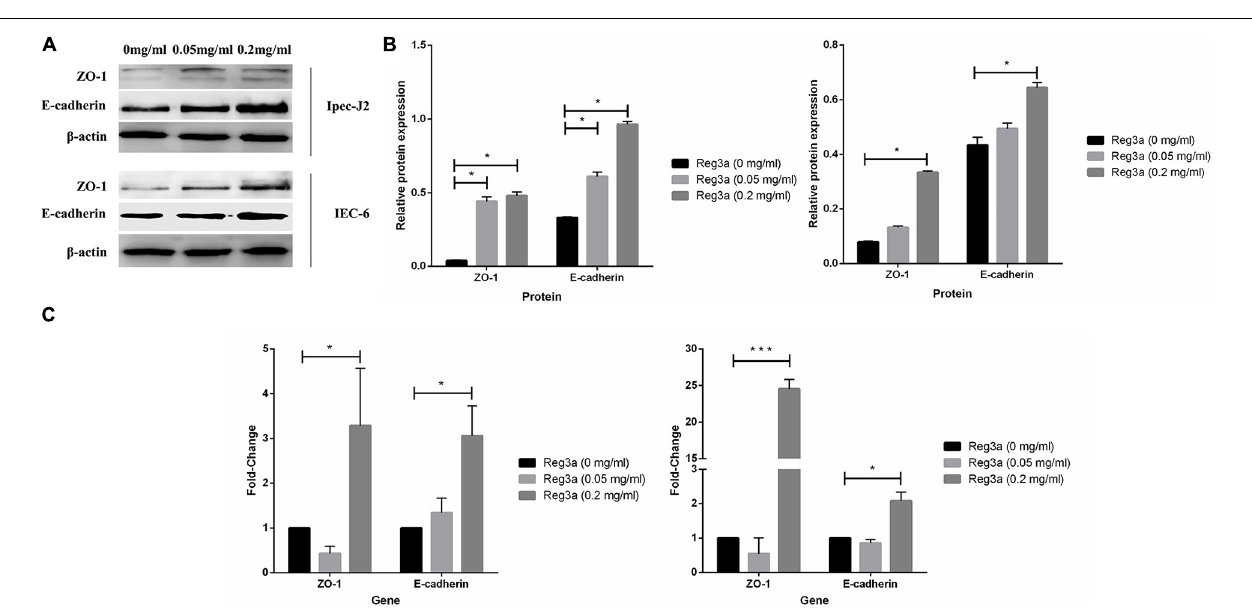
with a final concentration of 0.2 mg/ml within 6, 12, and 24 h ( p < 0.05) ( Figure 8C